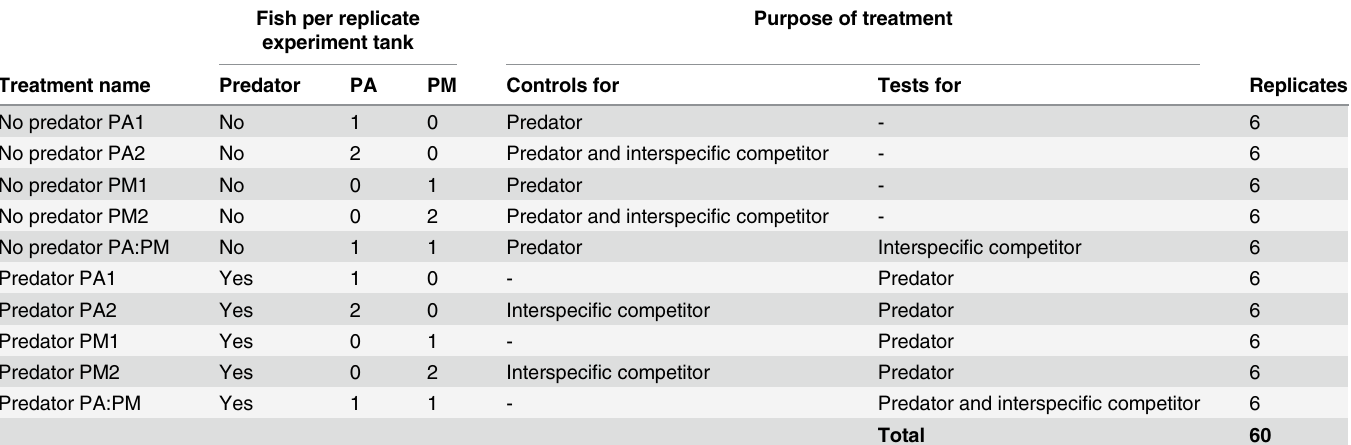
Table 1. Sampling design of experiment, with treatment names as they are referred to throughout the text. PA = Pomacentrus amboinensis , PM = Pomacentrus moluccensis . Numbers refer to fish per replicate tank (e.g. PA2 = 2 PA per tank), PA: PM indicates one individual of each species per replicate